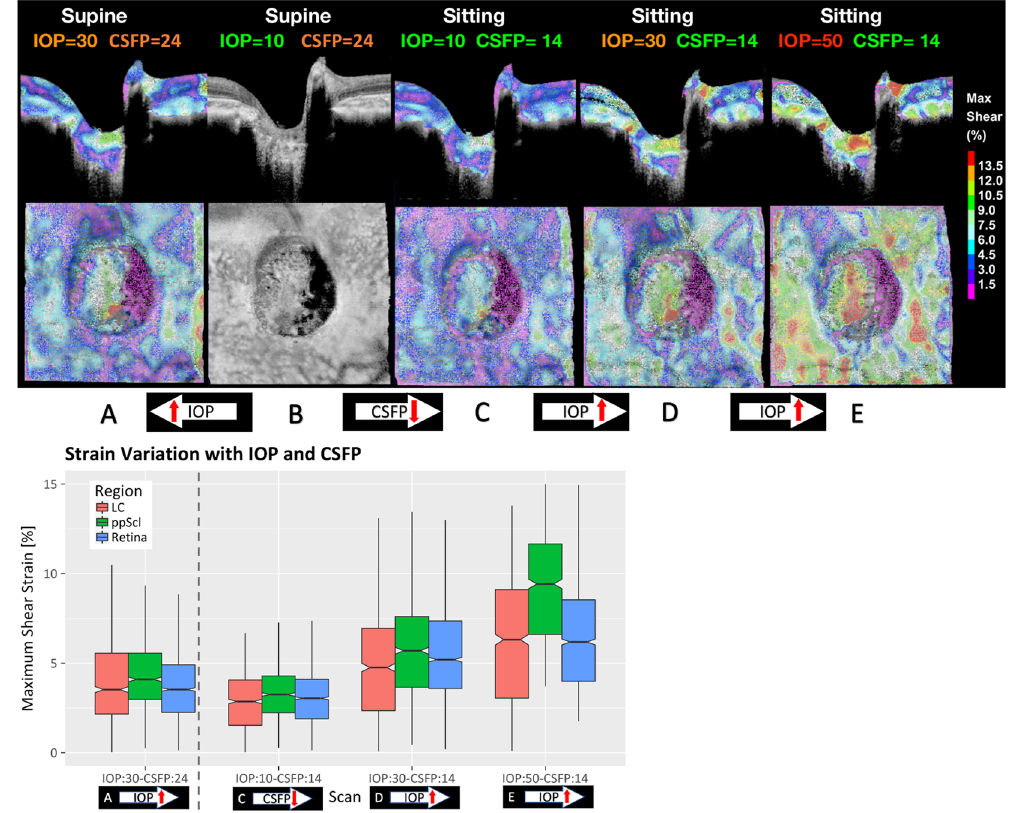
(B- > C vs. B- > A): lowering of CSFP alone (B- > C) induces LC strain similar to elevation in IOP (B- > A): comparing (B- > D vs. B- > A): the same IOP increase, there is higher strain increase in the scan at lower CSFP (D vs. A). ( l ) Box-whisker plots of the regional strain distribution for the follow-up